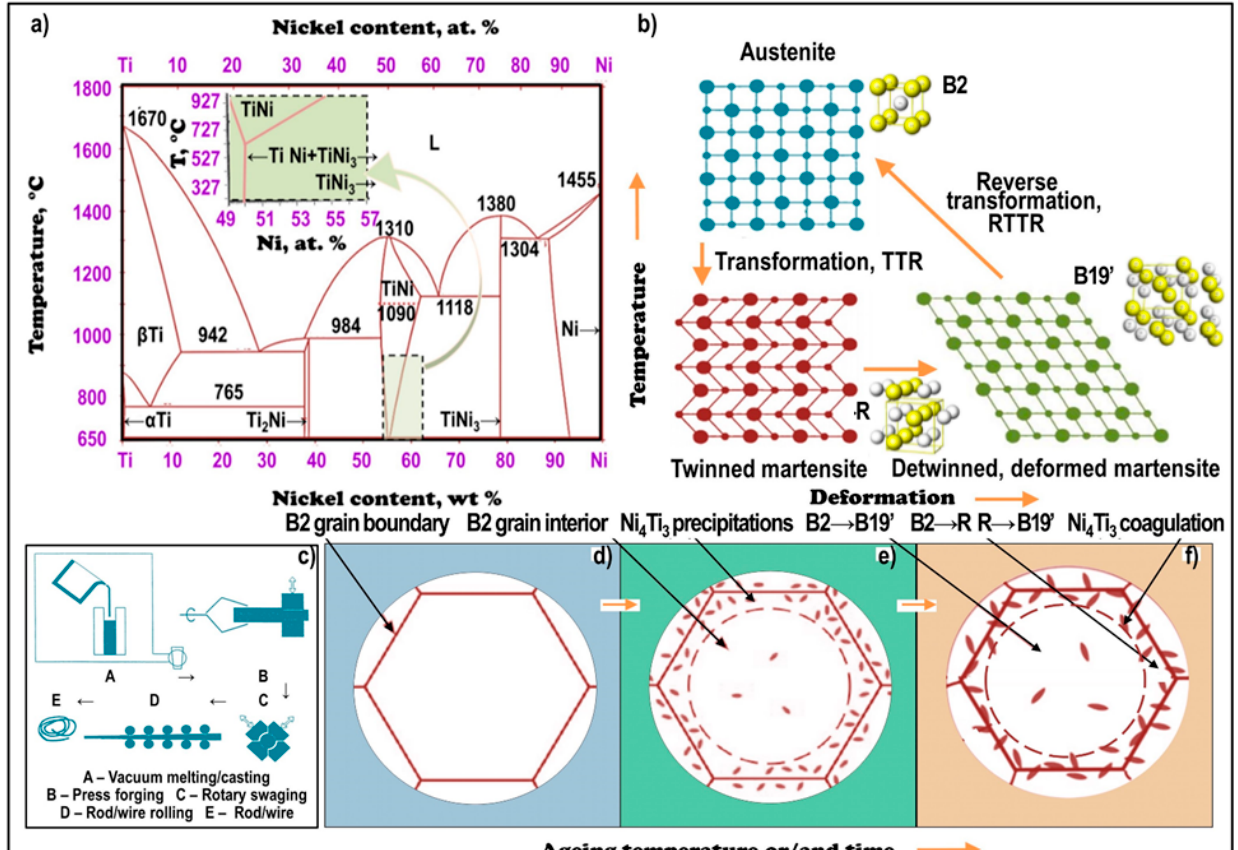
Figure 5. Diagram of information on nitinol alloys: ( a ) Ti–Ni phase equilibrium system; ( b ) diagram of phase transformations determining the shape memory and superelasticity effects; ( c ) diagram of the technological process of nitinol-type substances; ( d ) structure of austenite B2; ( e ) separation of Ni 4 Ti 3 in the border zone of austenite B2; ( f ) coagulation processes of precipitates in the austenite border zone favouring the transformation of B2 → R and then R → B19 ′ with the B2 grain interior not changing the chemical composition, in which a one-stage martensitic transformation takes place (B2 → B19 ′ ).